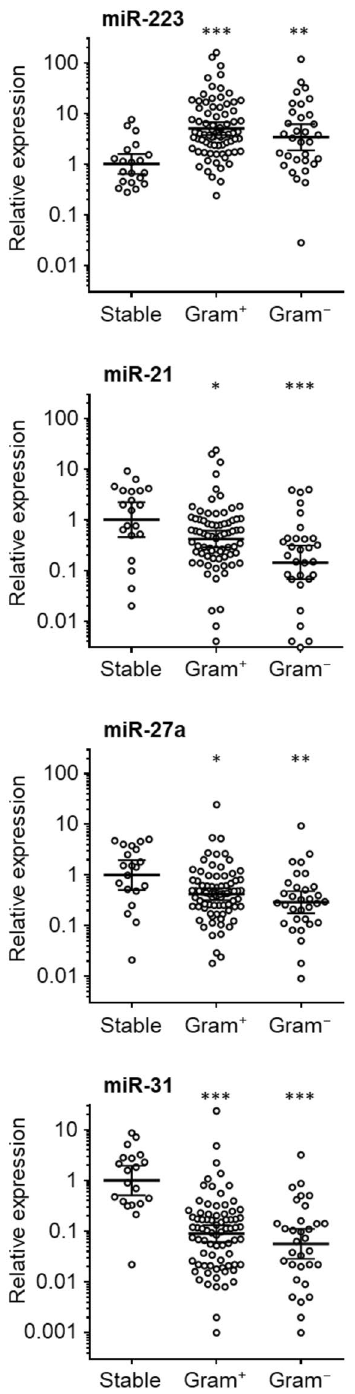
Figure 1. Peritoneal microRNAs in PD patients with and without acute bacterial peritonitis. Levels of miR- 223, miR-21, miR-31 and miR-27a were measured in effluent samples from 20 stable PD patients, 76 patients with confirmed Gram + infections and 31 with Gram − infections, and normalised to snRNA U6. Each data point represents an individual patient; lines indicate geometric means and 95% confidence intervals. Data were analysed using Kruskal-Wallis tests combined with Dunn’s multiple comparisons tests versus stable